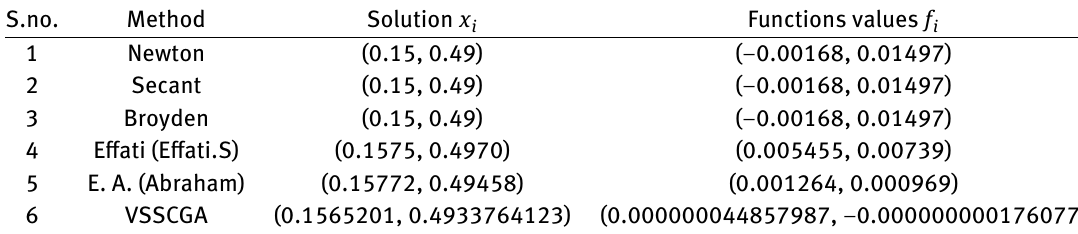
Table 3: Comparison of VSSCGA’s results with earlier results for Effati and Nazemi example 1 S.no.